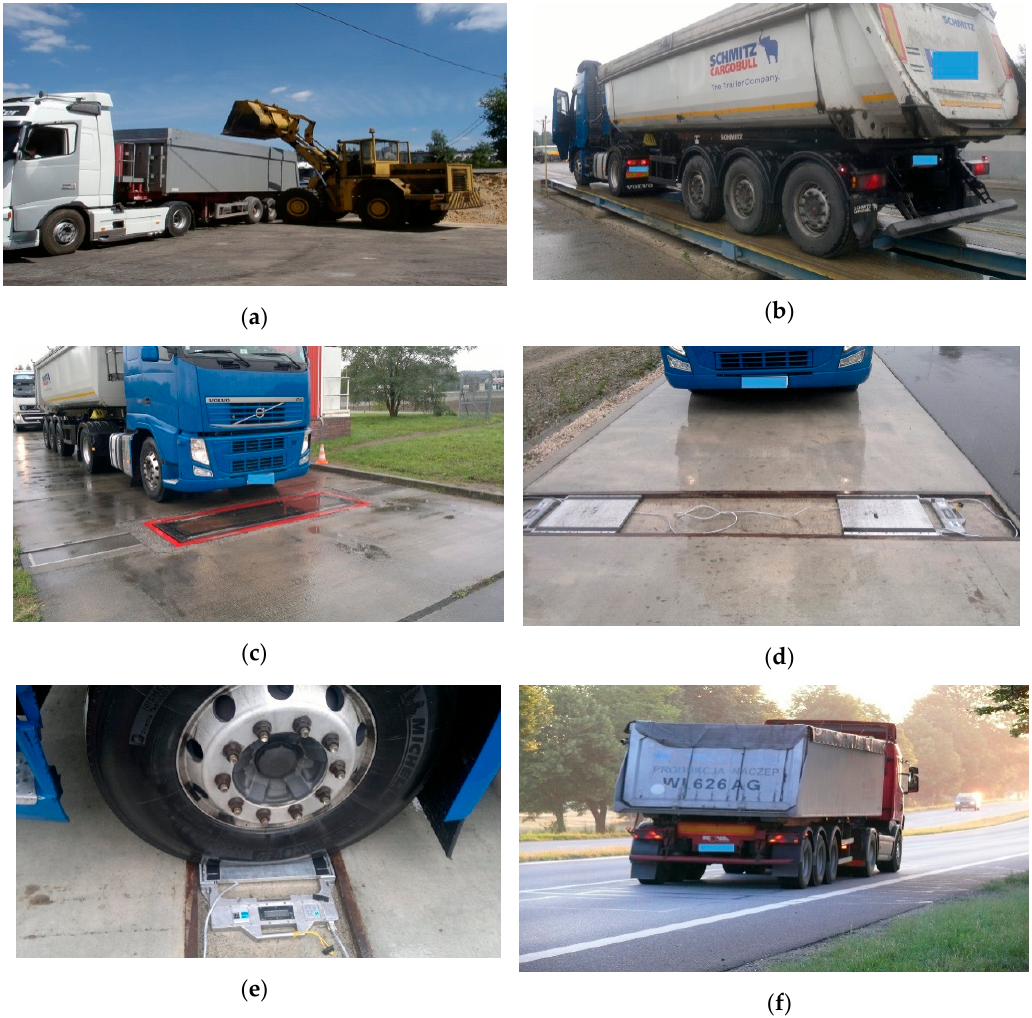
Figure 3. Preparation of reference vehicles: ( a )—loading the vehicle with gravel; ( b )—the measurement of GVW on a platform scale; ( c )—the measurement of axle load and GVW on a low-speed scale; ( d , e )—the measurement of static axle load on a static scale; ( f )—weighing of the vehicle at the MS-WIM site. Table 1. Parameters of reference vehicles.